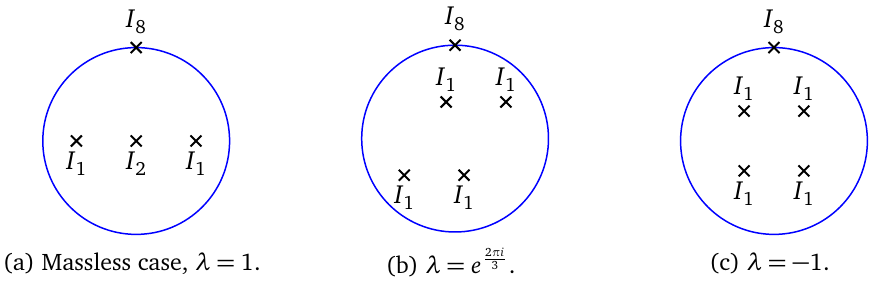
E theory for some values of λ . Notice the (cid:90) S 1 1 at λ = − 1. 4